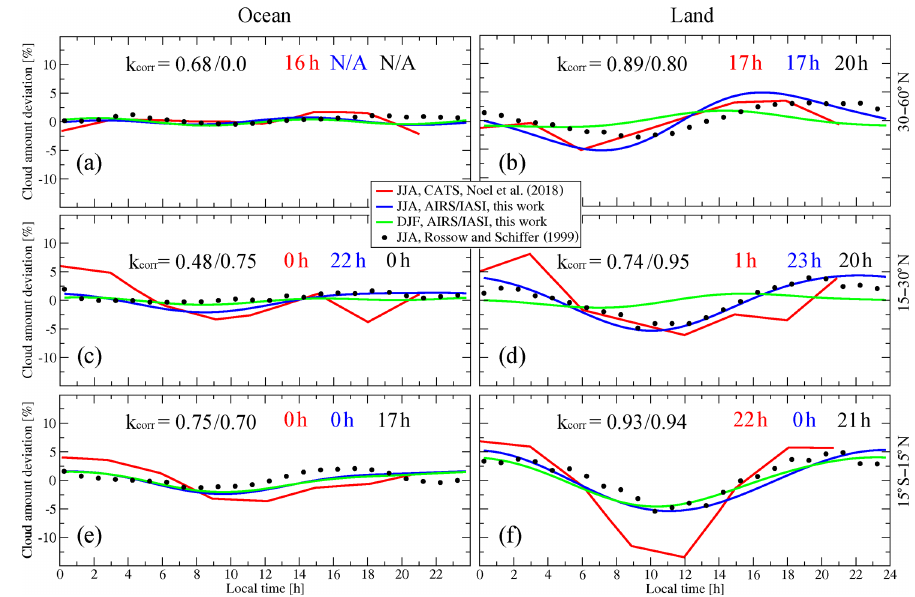
Figure 3. Comparison of average diurnal cycles of high-level cloud coverage over three latitudinal bands estimated from CATS lidar ob- servations (Noel et al., 2018), from AIRS/IASI (this work), and from ISCCP (Rossow and Schiffer, 1999). CATS statistics only includes June, July, and August (JJA, red curves), whereas AIRS/IASI results are shown both for boreal summer (JJA, blue curves) and boreal winter (December, January, and February, DJF, green curves) in 2008–2015. The ISCCP JJA data cover the period of 1989–1991. The correlation coefficients are given for AIRS/IASI vs. CATS and AIRS/IASI vs. ISCCP sequences for JJA in the upper left part of each panel; the peak local times for CATS are marked in red, for AIRS/IASI in blue, and for ISCCP in black in the upper right part of each panel. (a) 30–60 ◦ N,